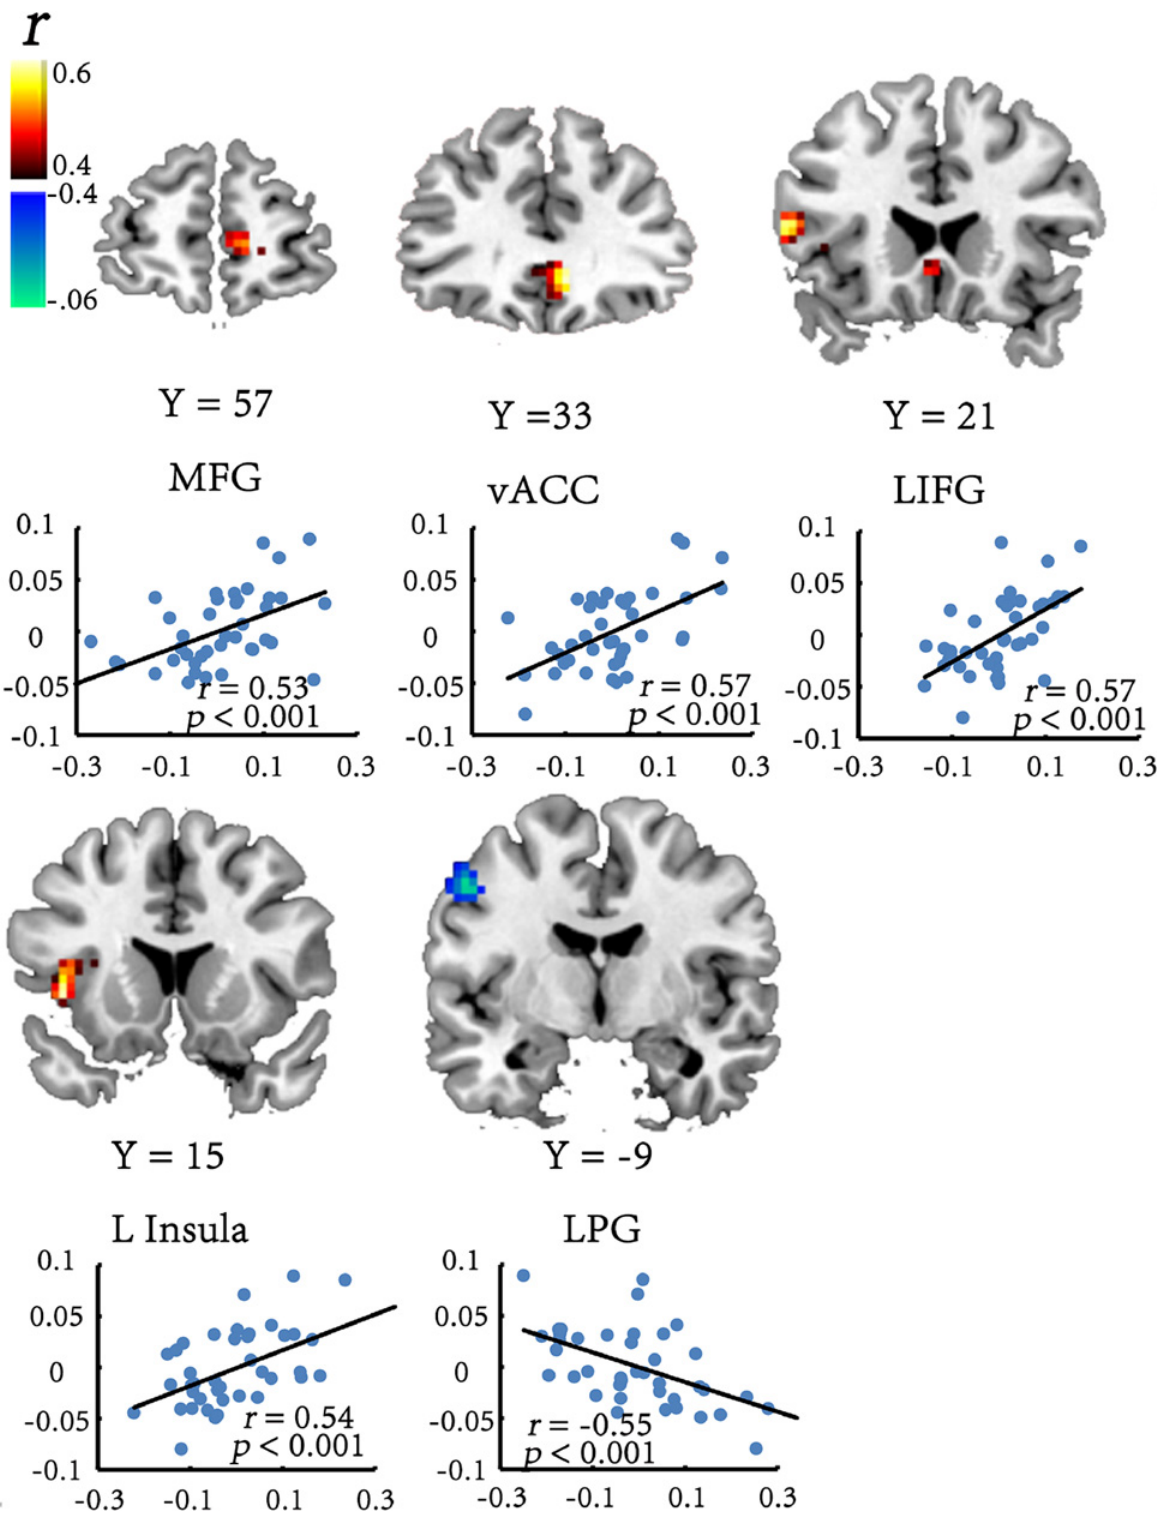
Fig 2. Brain regions which exhibit significant correlations between ReHo and participants ’ cognitive control efficiency [expressed as (I-C)/mean RT] in the Stroop task. The numbers at the bottom of each image refer to the y-coordinates of the Montreal Neurological institute (MNI). The threshold was set at p < 0.05 (corrected). Each scatter plot shows the correlation between the cognitive control efficiency and averaged ReHo in the corresponding region with gender, age and FD controlled. x-axis, ReHo value; y-axis, Stroop effect. Each dot represents data from one participant. doi:10.1371/journal.pone.0124405.g002 PLOS ONE | DOI:10.1371/journal.pone.0124405 May 4,